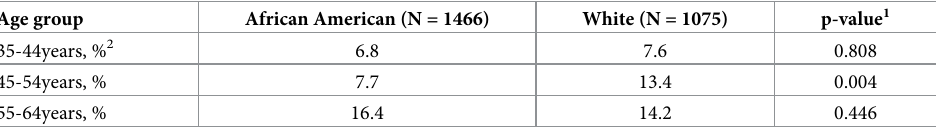
Table 2. Frailty prevalence by race and age